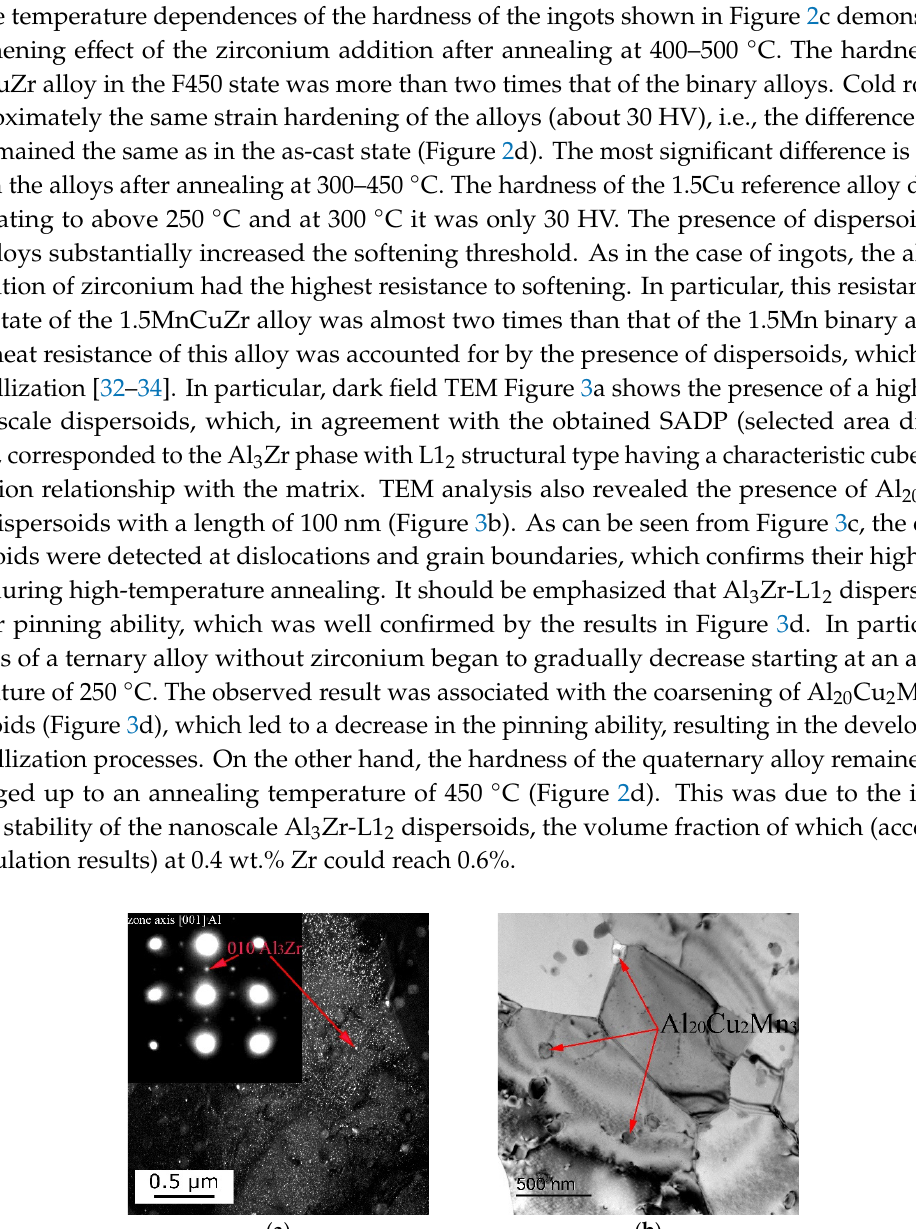
Figure 3. Dispersoids of Al 3 Zr ( a,c ) and Al 20 Cu 2 Mn 3 ( b,c ) in cold rolled alloy 1.5MnCuZr after annealing: ( a–c ) at 400 °C (state CR400), TEM and ( d ) at 600 °C (state CR600), SEM. ( a ) Dark field and diffraction patterns and ( b,c ) bright field.